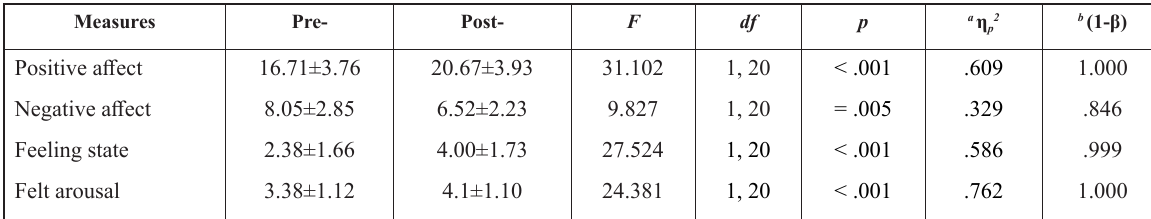
Table 2. Means ± standard deviations and the results of the univariate repeated measures analysis of variance determining the differences in psychological measures pre- and post-laughter yoga session (Study 2) Measures Pre-